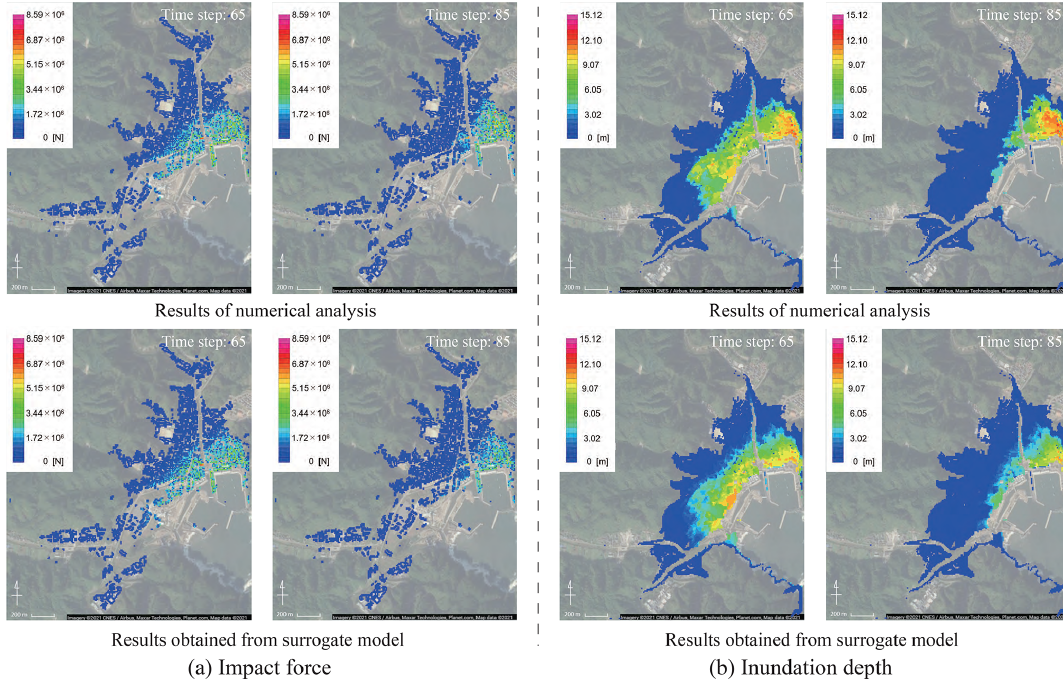
Figure 18. Snapshots of the results obtained from numerical analysis and those obtained from the surrogate models (S2R3) (© Google Maps).